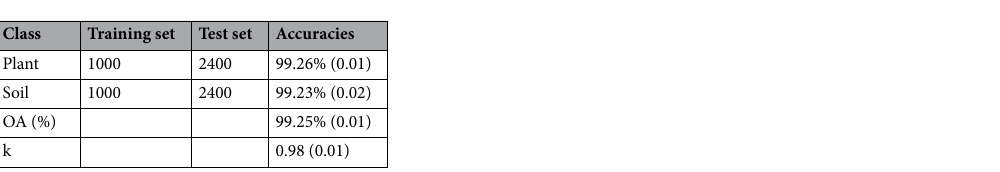
Table 1. Performance of the binary classification to estimate the plant and soil